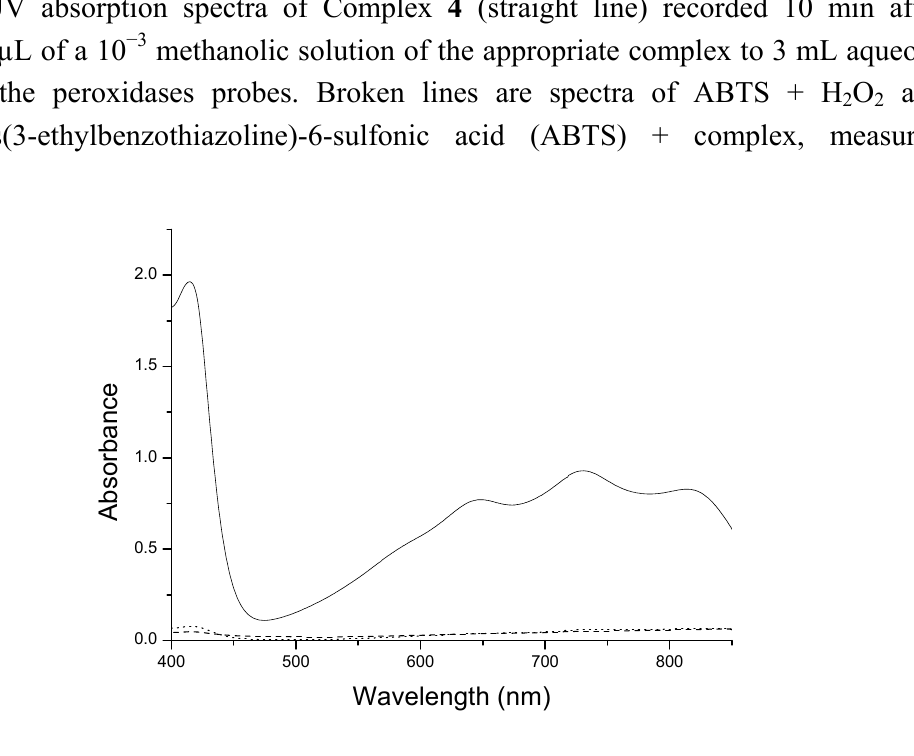
Figure 4. UV absorption spectra of Complex 4 (straight line) recorded 10 min after injecting 10 µL of a 10 − 3 methanolic solution of the appropriate complex to 3 mL